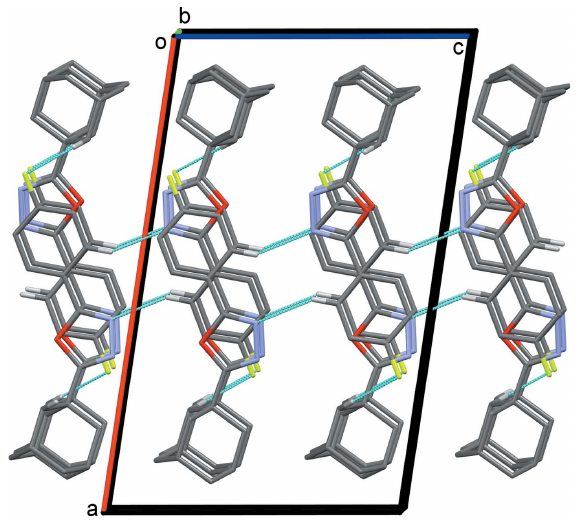
Figure 4 A view along the b axis of the crystal packing of compound (I). The